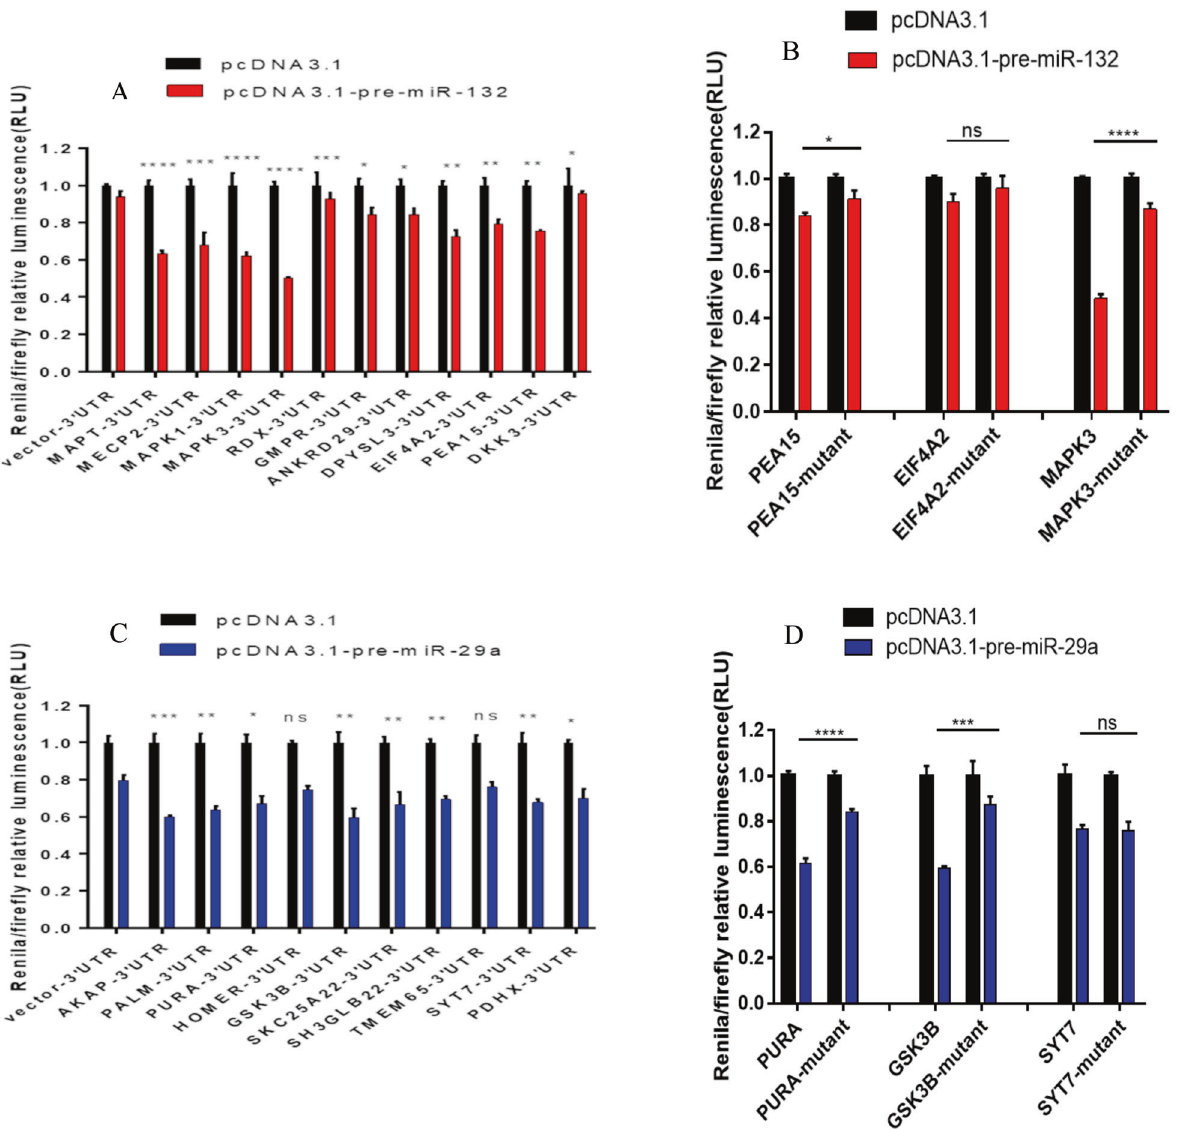
Fig. 4 Validation of the targets of miR-132 and miR-29a. This fi gure shows the results for the Renilla Luciferase assays for the 3 ’ UTR for a selected number of cognitive trajectory-associated genes. A Relative R-luc/F-luc ratio in the co-transfection of miR-132 potential targets 3 ’ UTR- reporter constructs with pcDNA3.1-pre-miRNA-132 vs. pcDNA3.1 (as control) in HEK 293 T cells. B Rescue experiments to further validate the targets of miR-132 using respective 3 ’ UTR-reporter construct mutant. C Relative R-luc/F-luc ratio in the co-transfection of miR-29a potential targets 3 ’ UTR-reporter constructs with pcDNA3.1-pre-miRNA-29a vs. pcDNA3.1 (as control) in HEK 293 T cells ( N = 3, ns = not signi fi cant, * p < 0.05, ** p < 0.01, *** p < 0.001, **** p < 0.0001). D Rescue experiments to further validate the targets of miR-29a using respective 3 ’ UTR-reporter construct their mRNA or protein expression levels positive correlated with the levels of miR-132 or miR-29a, respectively. One possible explanation is that we studied miRNAs, mRNAs, and proteins pro fi led from postmortem brain tissue, which is cross-sectional by nature, and their directions of association in real time cannot be adequately captured. Another possible contributing factor is the dynamic interactions between miRNAs and their target genes as recent work have shown bi-directional interactions between miRNAs and their targets and that targets of miRNAs can in fl uence each other ’ s expressions [50, 51]. Third, the proteomic dataset was not from the discovery/replication cohort used for the because they were the sum of 17 different cognitive tests for each miRNA pro fi ling so the identi fi cation of the targets of miR-132 and participant. Fourth, we rigorously adjusted for multiple potential miR-29a, respectively, at the brain protein level is tentative and